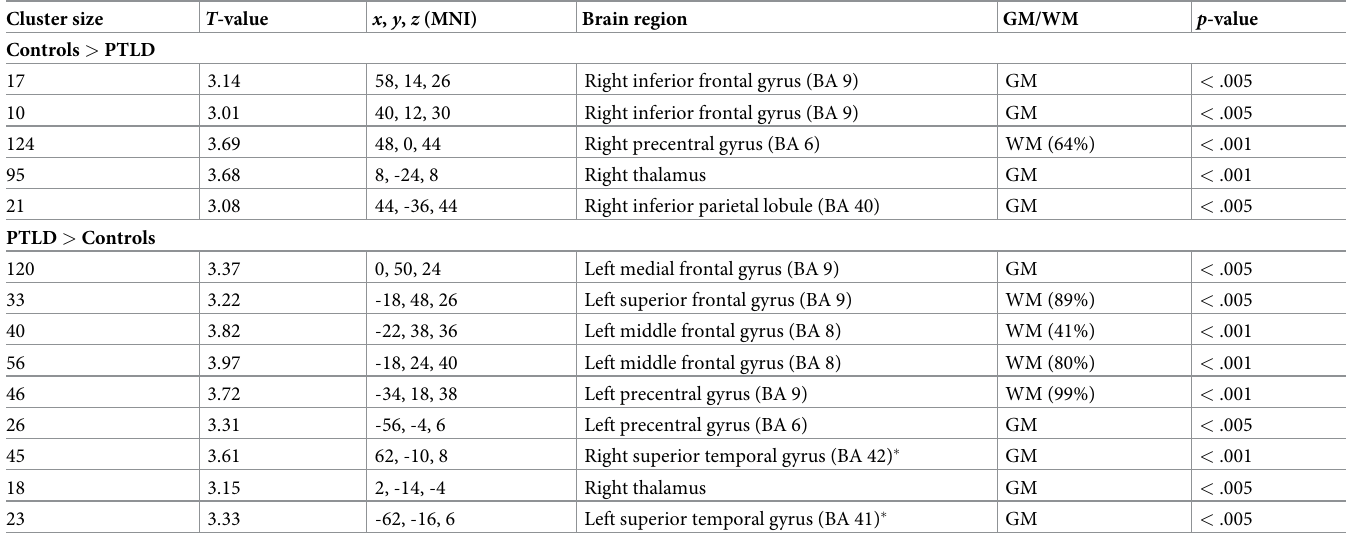
Table 2. Task-related BOLD activations between PTLD and control participants. Regions are based on Talairach coordinates 27 and listed anterior-posterior (y-plane). Cluster size